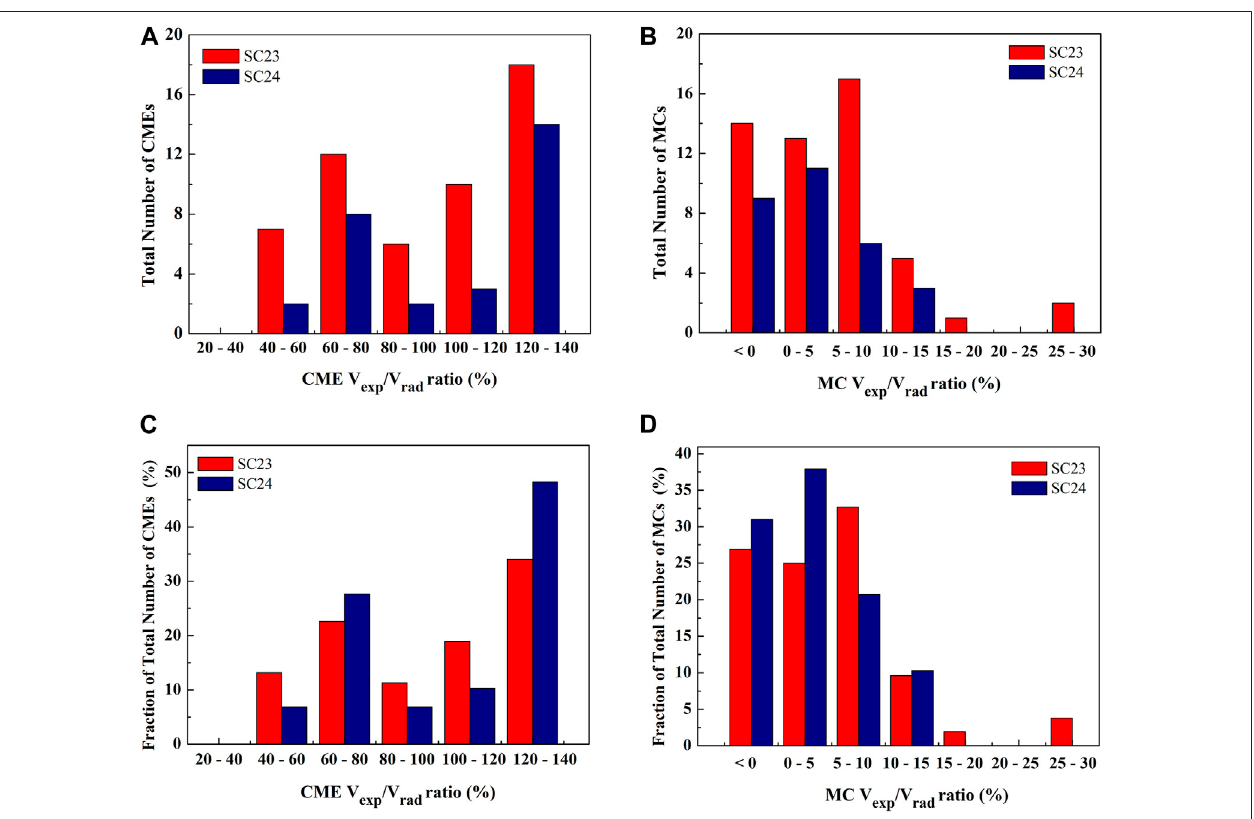
FIGURE 4 | The distributions of the ratio of radial expansion (V exp ) to radial propagation speed (V rad ) of CMEs near the Sun and associated MCs at 1 AU for solar cycles23and24areshown. (A),(B) and (C),(D) showthedistributions forthetotalnumberofCMEs/MCsandthepercentage fraction ofthetotalnumber ofCMEs/MCs in each bin,